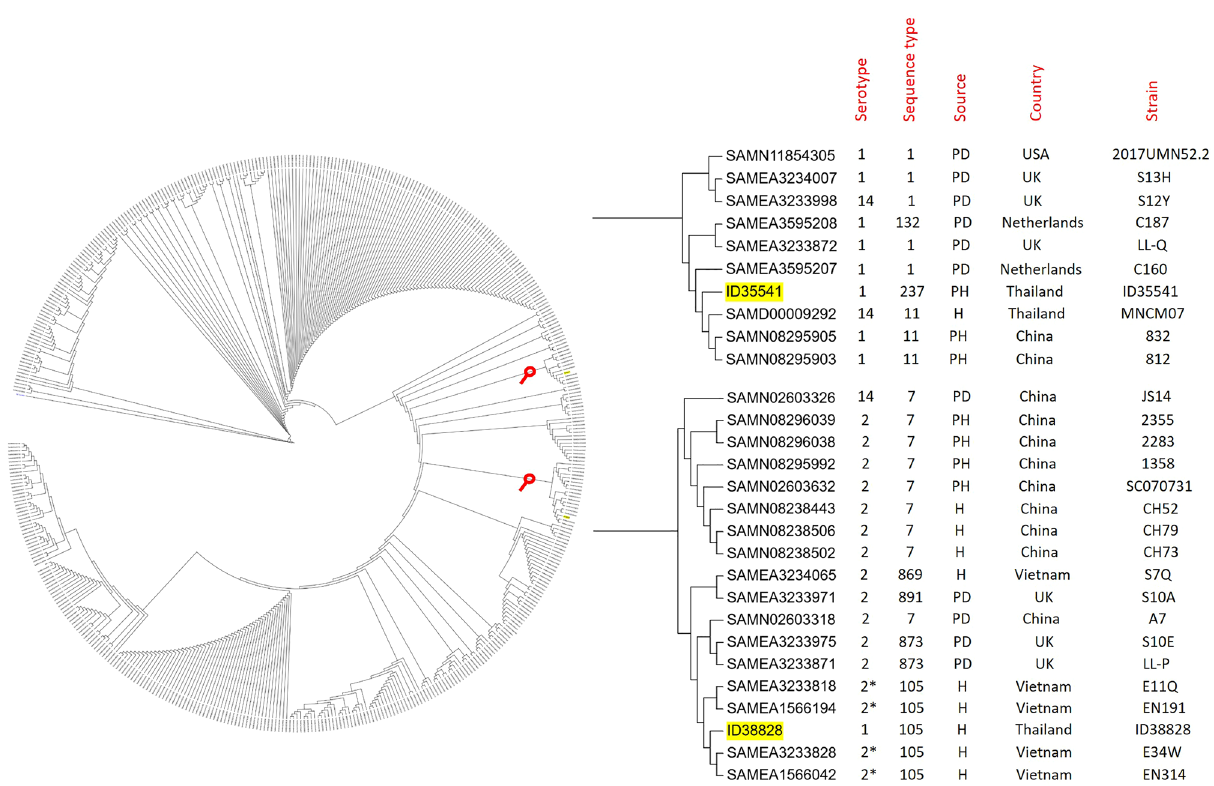
Figure 3. A phylogenetic tree based on the core genome SNPs of 430 genomic sequences of S. suis clonal complex 1 was constructed using the maximum likelihood method by FastTree v2.1.10 tool and visualized using interactive Tree of Life tool. The whole genome sequence of S suis serotype 1 strains in the current study are highlighted in yellow. * These original serotype 2 strains assigned in BioSample of GenBank were retyped as serotype 14 in this